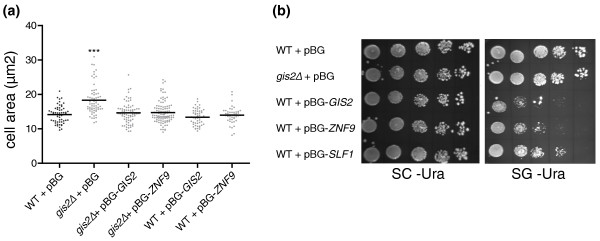
Phenotypic analysis of yeast cells. (a) Cell-size analysis. Wild-type (WT) and gis2Δ cells harboring either the empty vector (+ pBG) or galactose-inducible GIS2 or ZNF9 were grown in synthetic medium supplemented with 2% galactose to late mid-log phase. The cell area relating to the cell-size is depicted for 50 cells and the average is marked with a black line (***P < 0.0001). (b) Vegetative growth. WT cells or gis2Δ cells harboring either the empty vector (+ pBG) or galactose-inducible GIS2, ZNF9 or SLF1 (positive control for vegetative growth defect) were serially diluted (1:5) and spotted on the indicated plates: SC -Ura, synthetic complete medium lacking uracil; SG -Ura, the same as SC -Ura but also containing galactose instead of 2% glucose.